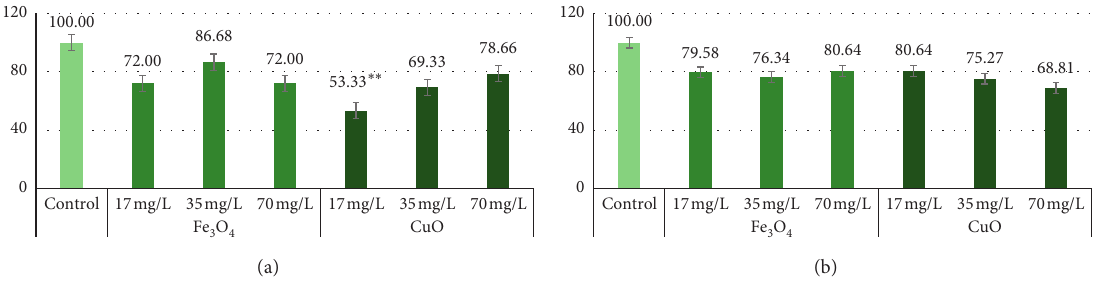
3 O 4 and CuO NPs